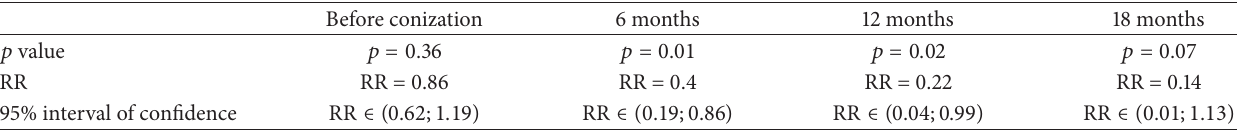
Table 5: The 𝑝 value obtained using 𝜒 2 test, comparing coinfections with HPV 16 and other HPV types and only HPV 16. Coinfection including type 16 was not correlated with higher persistence rate than infection with type 16